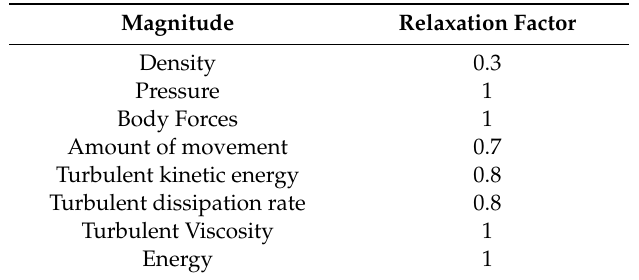
Table 3. The relaxation factors applied to the numerical